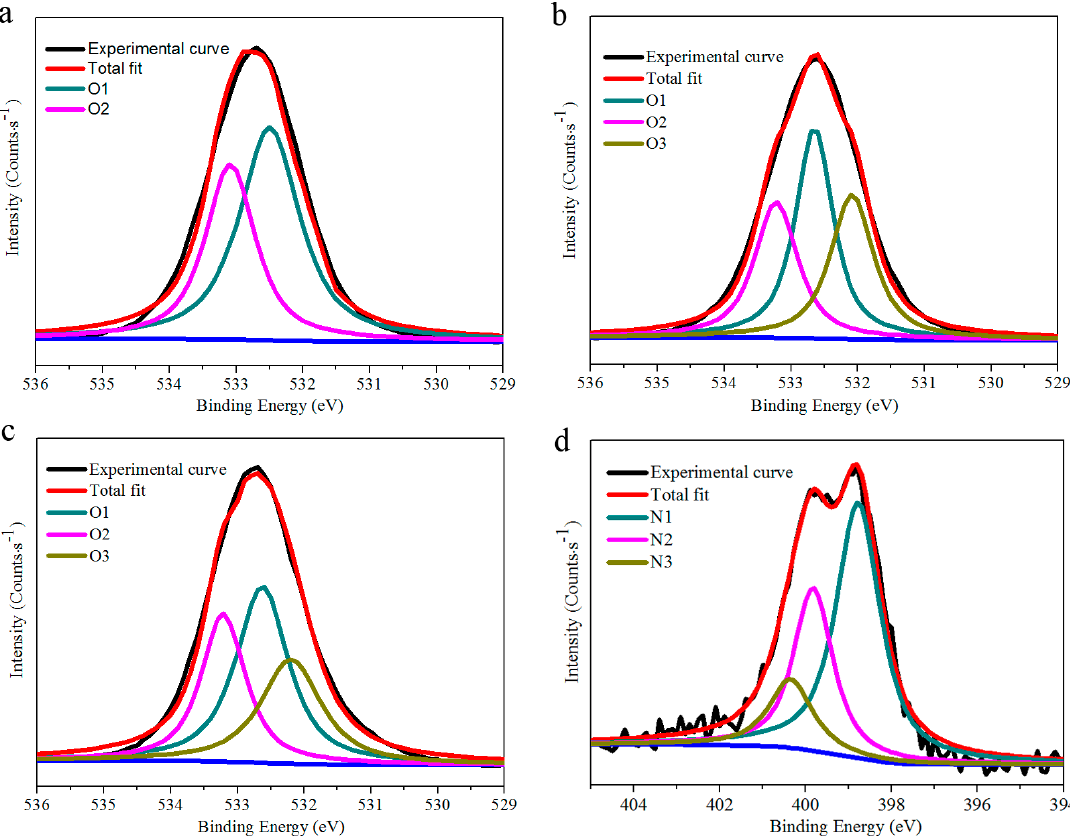
Figure 4. Curve fit of ( a ) O1s peaks of BC; ( b ) O1s peaks of oxidized BC; ( c ) O1s peaks of CoPc@BC; and ( d ) N1s peaks of CoPc@BC.